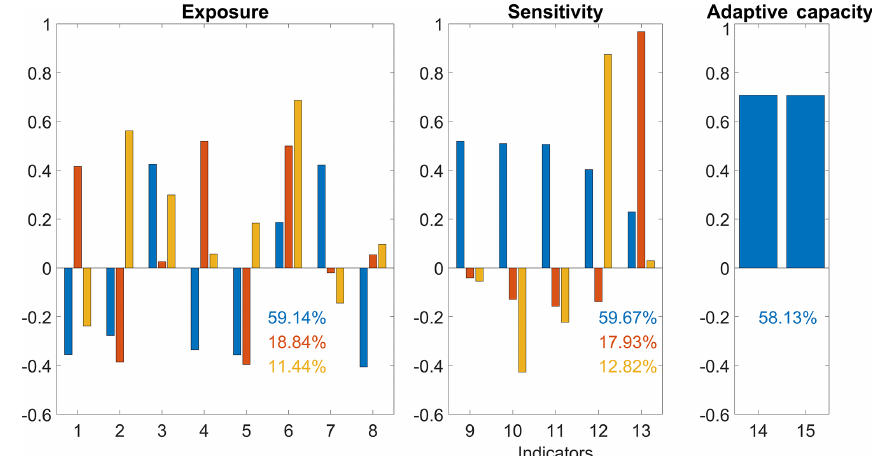
Figure 6. Loading factors of original 15 indicators corresponding to each PC (PC 1 – blue; PC 2 – orange; PC 3 – yellow) used to represent the components: X values correspond to the original indicators described in Table 1. The percentage of variance explained for each PC is presented in the bottom right corner.